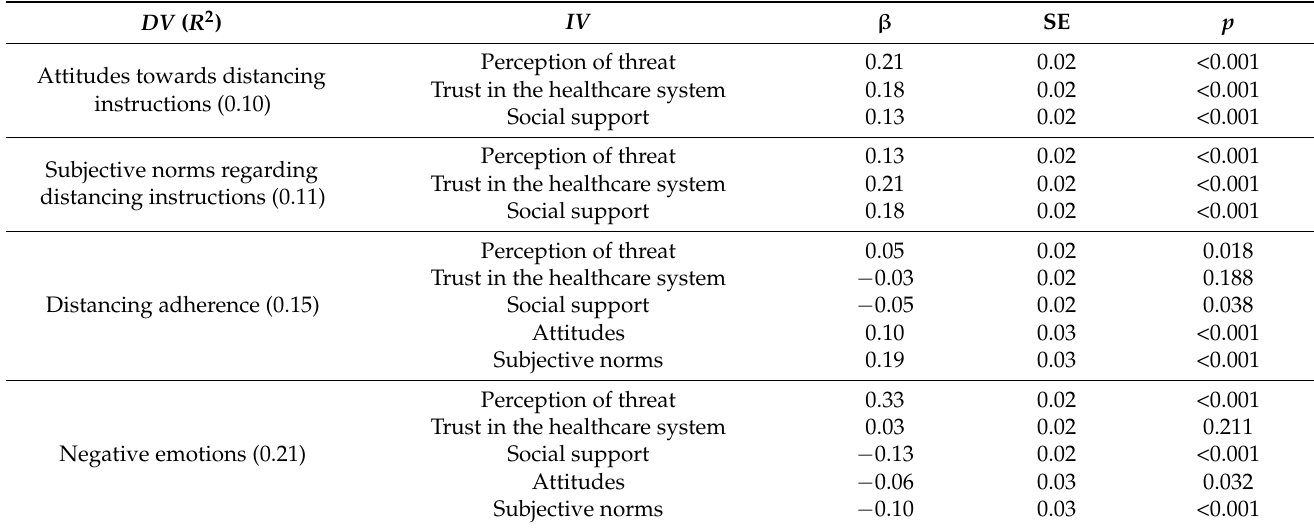
Table 3. Direct relationships among threat, trust, social support, attitudes, and subjective norms towards distancing adherence and negative emotions ( N = 1822).